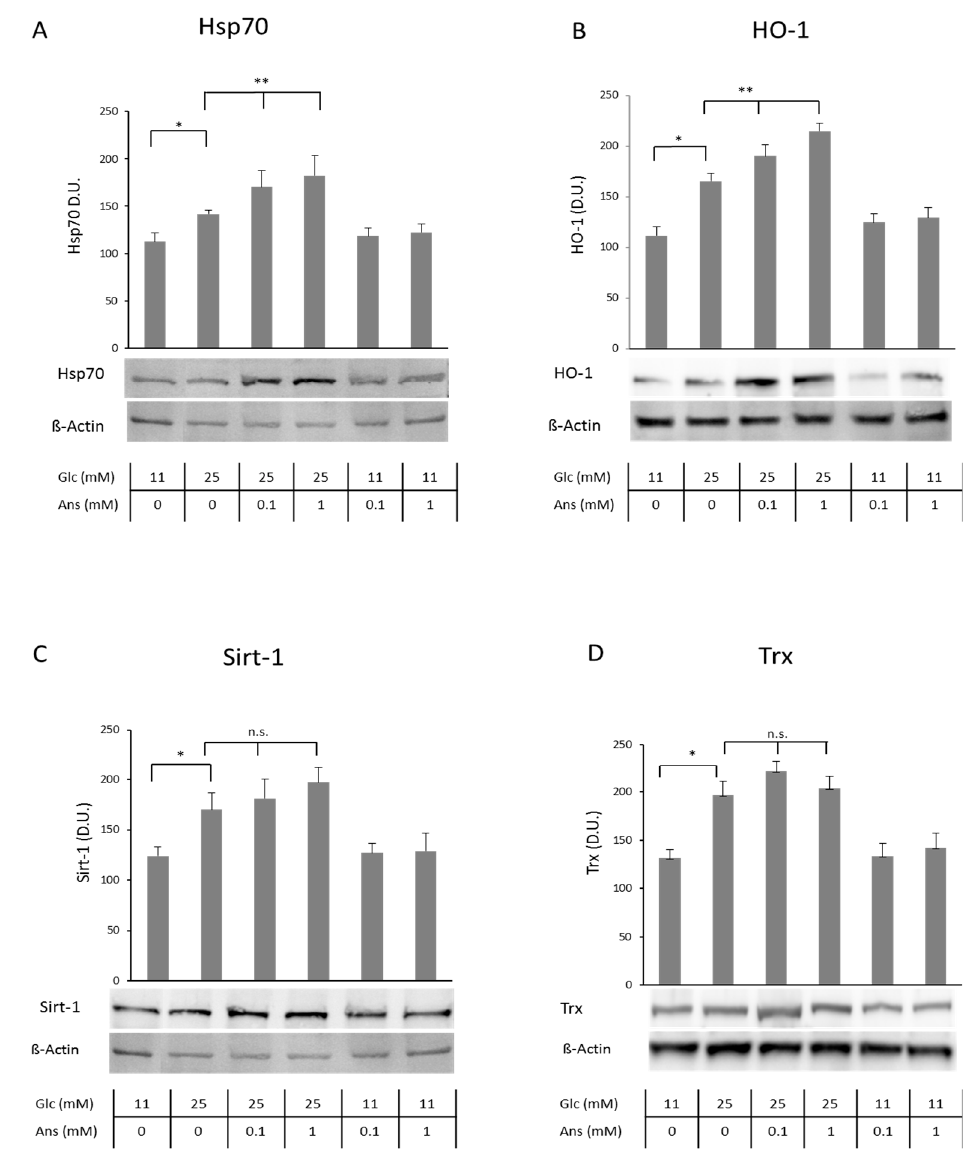
Figure 1. Effect of co-incubation with high glucose and anserine in human tubular cells (HK-2) on cellular heat shock protein 70 (Hsp70), hemeoxygenase (HO-1), Sirtuin-1 (Sirt-1) and Thioredoxin (Trx). Hsp70 ( A ), HO-1 ( B ), Sirt-1 ( C ) and Trx ( D ) cellular protein concentrations significantly increased in HK-2 cells with glucose stress (25 mM for 24 h), determined by Western blotting, compared to cells incubated with medium containing normal glucose concentration (11 mM). Densitometric units (D.U.) after normalization against β -actin are given ( n = 3). Co-incubation with anserine (0.1 and 1 mM) further increased Hsp70 and HO-1 protein but had no additional effect on Sirt-1 and Trx. Anserine alone does not alter tubular cell defense systems. p < 0.05 (*); p < 0.01 (**); n.s. = not significantly.